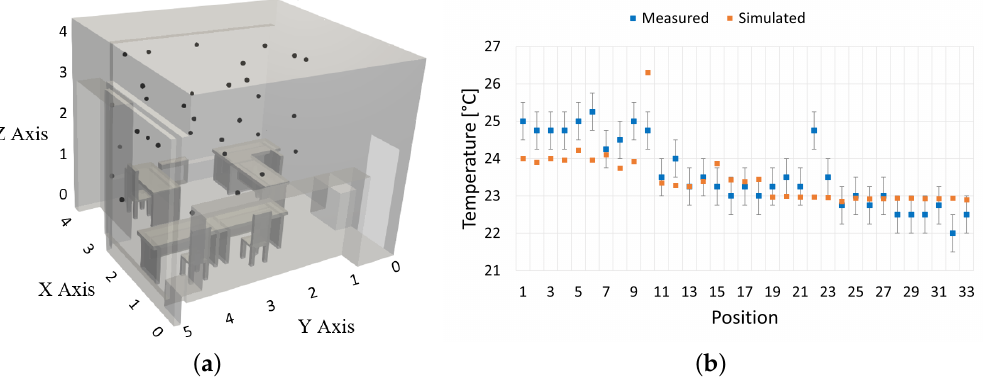
Figure 4. ( a ) Positions of the sensors for model validation. ( b ) Comparison of measured and simulated temperature values in the winter condition.